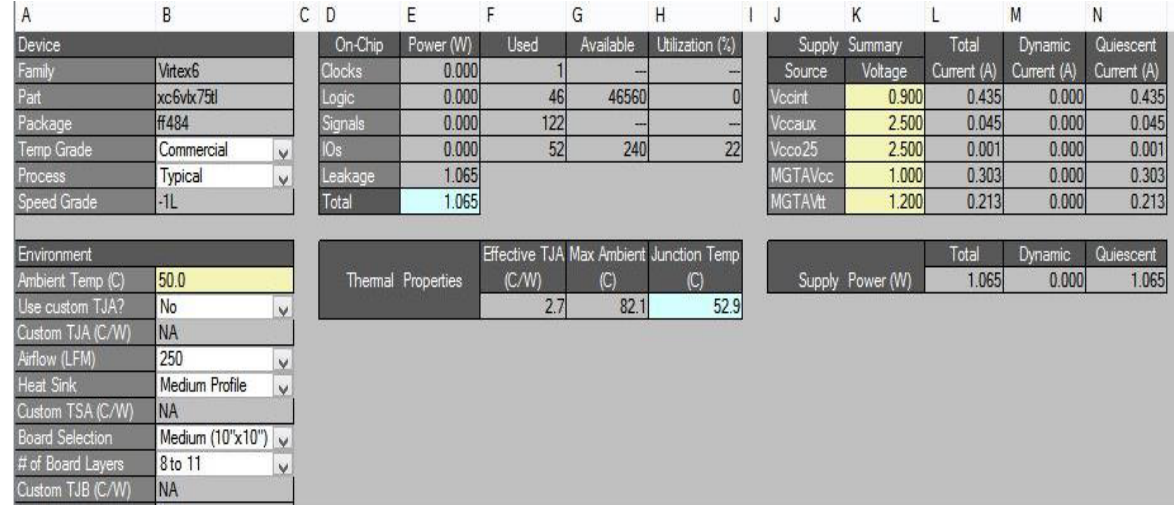
Figure 5. Power summary.